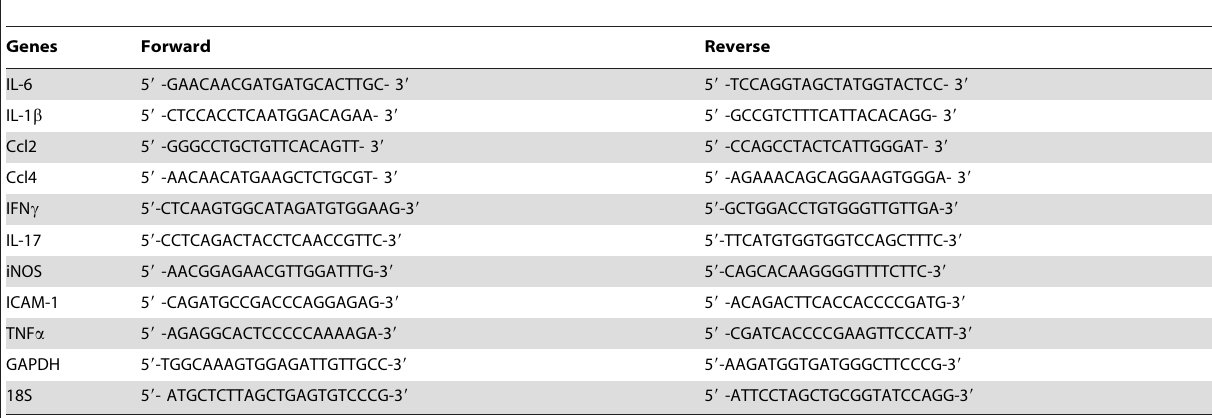
Table 1. The mouse primer sequences used in quantitative Polymerase Chain